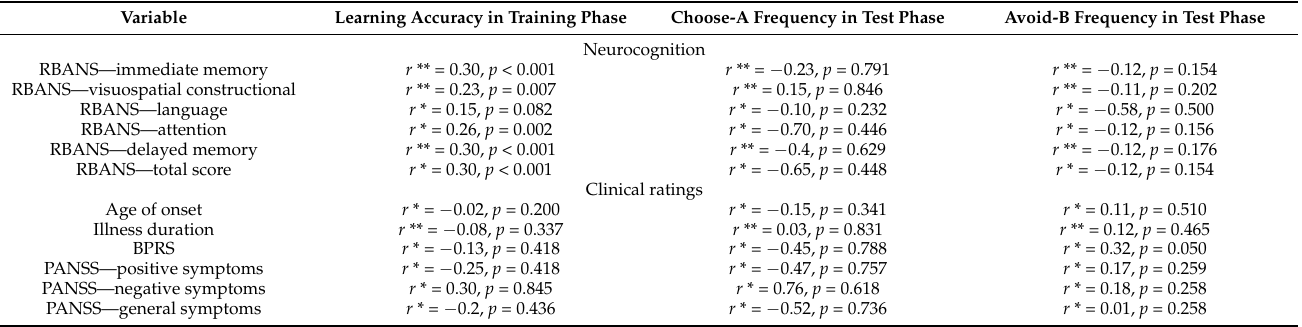
Table A2. Correlational analysis between training and test phase performance on PST with neurocog- nitive and clinical